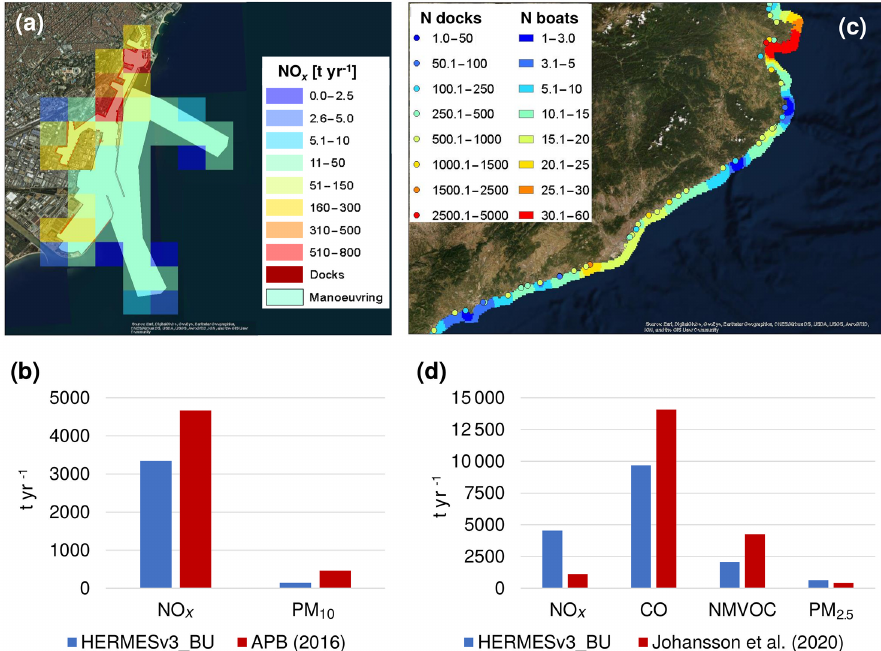
Figure 7. (a) Annual NO x emissions (tyr − 1 ) for the Port of Barcelona calculated on a regular 1km by 1km grid. Dark red and light blue layers represent the spatial proxies used to allocate hotelling and manoeuvring emissions, respectively. (b) Comparison between annual NO x and PM 10 of Barcelona’s port emissions (tyr − 1 ) estimated with HERMESv3_BU and reported by the Barcelona Port Authority inventory (APB, 2016). (c) Spatial distribution of Spanish marinas (with the associated number of docks) and recreational boats along the Costa Brava region (coast of Catalonia). (d) Comparison between annual NO x , CO, NMVOC and PM 2 . 5 pleasure boat emissions (tyr − 1 ) estimated for Spain (HERMESv3_BU) and the Baltic Sea region (Johansson et al., 2020). (Sources of the ArcGIS Online basemap: Esri, DigitalGlobe, GeoEye, i-cubed, USDA FSA, USGS, AEX, Getmapping, Aerogrid, IGN, IGP, swisstopo and the GIS user community. Maps in (a) and (b) were created using ArcGIS ® software by Esri. ArcGIS ® and ArcMap™ are the intellectual property of Esri and are used herein under license. Copyright © Esri. All rights reserved. For more information about Esri ® software, please visit https://www.esri.com (last access: February